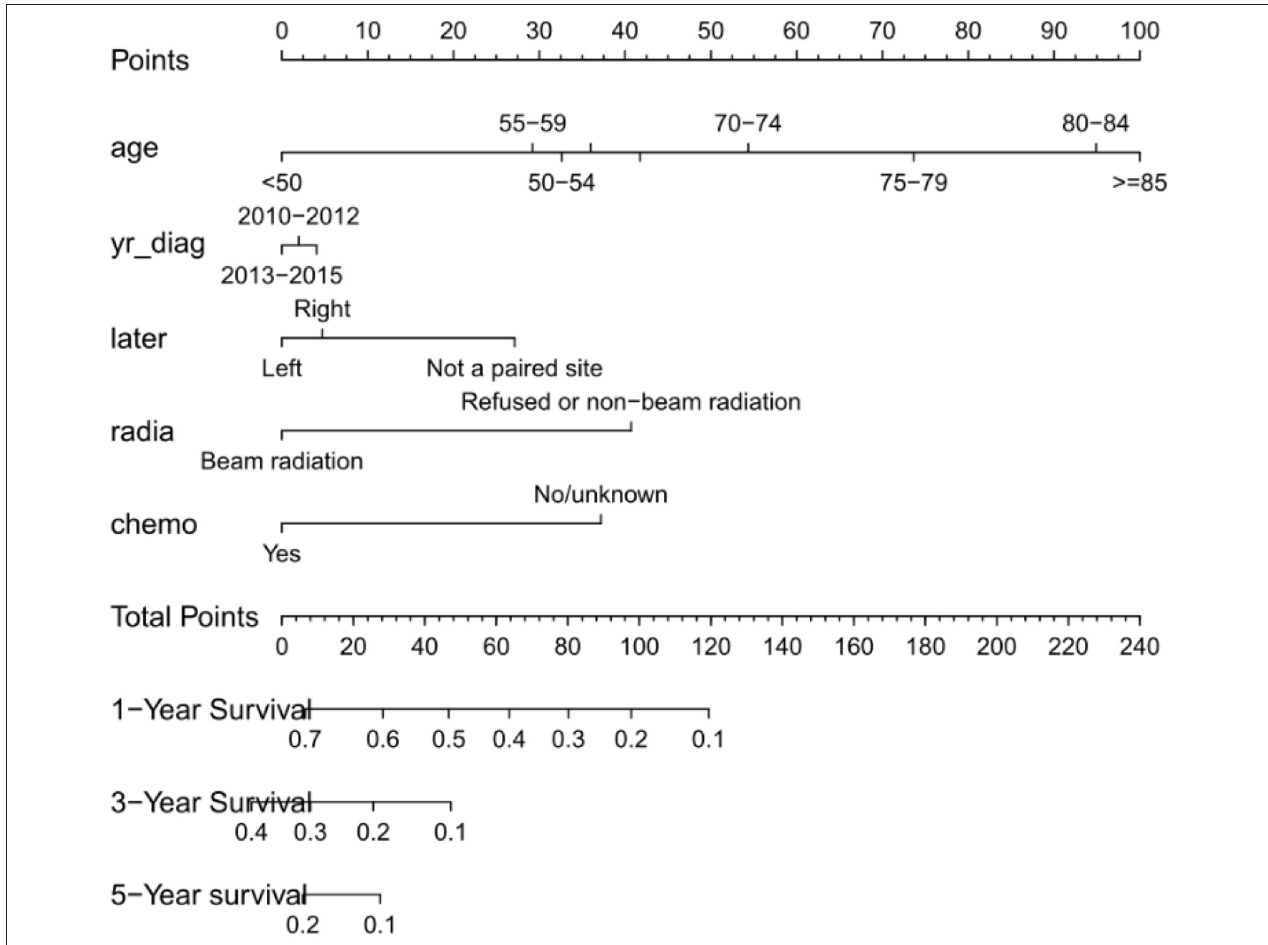
FIGURE 3 | Nomogram predicting patients’ 1 -, 3 -, and 5-years over survival with glioblastoma. The specific subtypes of each variables are projected to the point scale to obtain a value. The higher the value, the worse the prognosis of patients. The total value can be obtained by summing up the values of each variables. The 1-year, 3-years, and 5-years over survival of the patient can be obtained by downward projection of the total value in the total point scale. yr_diag, year of diagnosis; later, laterality; radia, radiation; chemo,